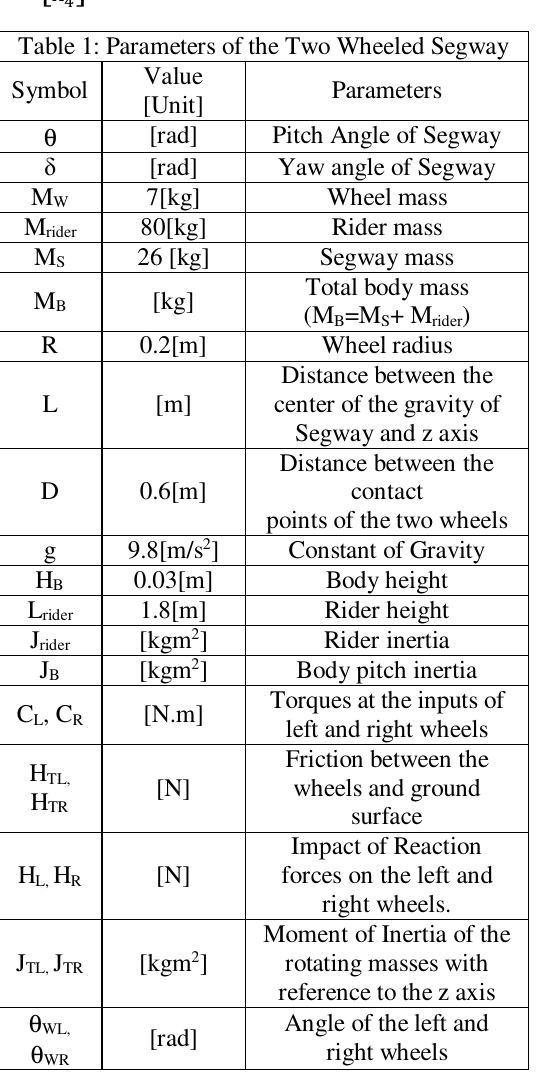
Table 1: Parameters of the Two Wheeled Segway